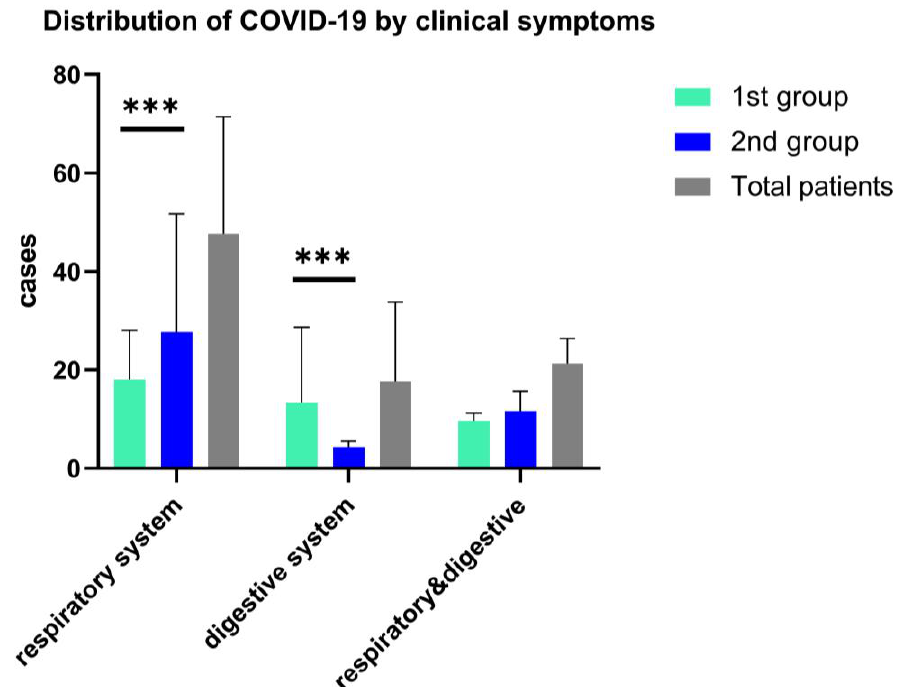
Figure 3. Distribution of COVID-19 in children by the onset clinical features, ***— p ≤ 0.001. Data are represented as mean with SD and shows the differences of respiratory and digestive symptoms and both clinical manifestations in a two-way ANOVA statistical analysis.